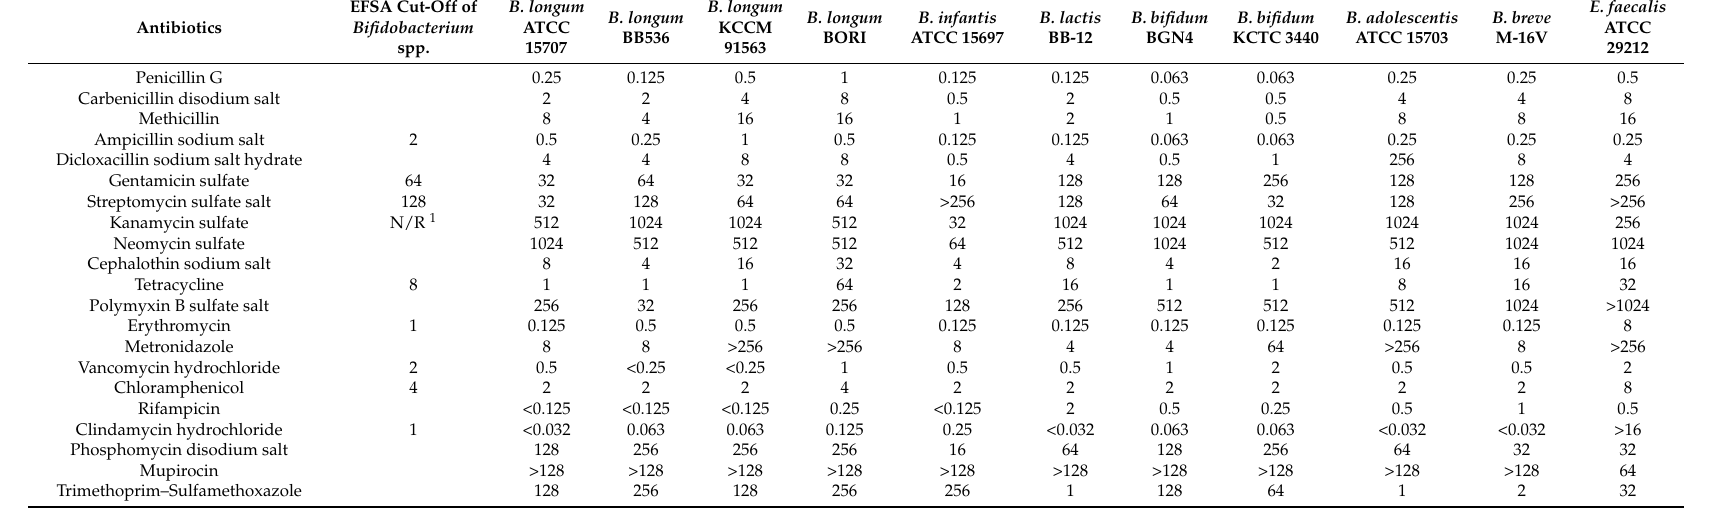
Table 3. Antimicrobial susceptibility (MIC values) of B. bifidum BGN4 and B. longum BORI and other Bifidobacterium